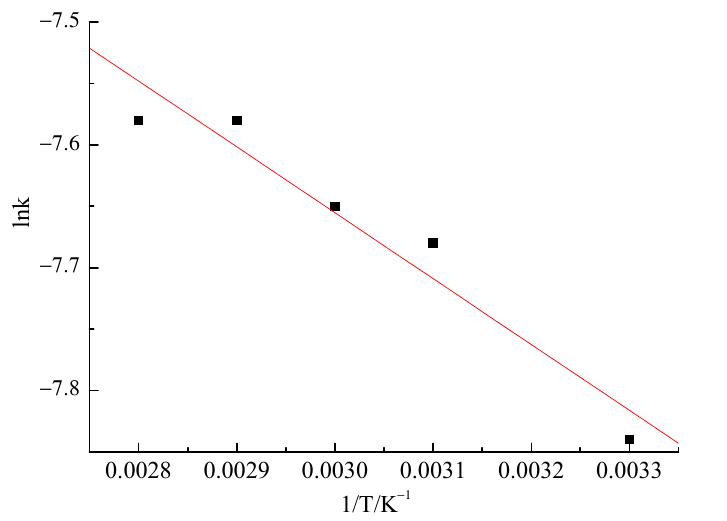
Figure 11. Relation of ln k and 1/ T (R 2 = 0.9358) for leaching times less than 120 min.